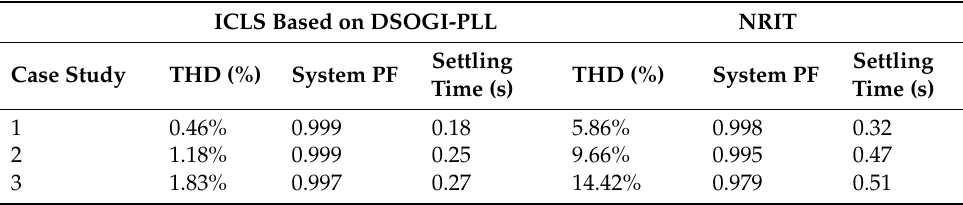
Table 5. Case study results for the proposed inverter control